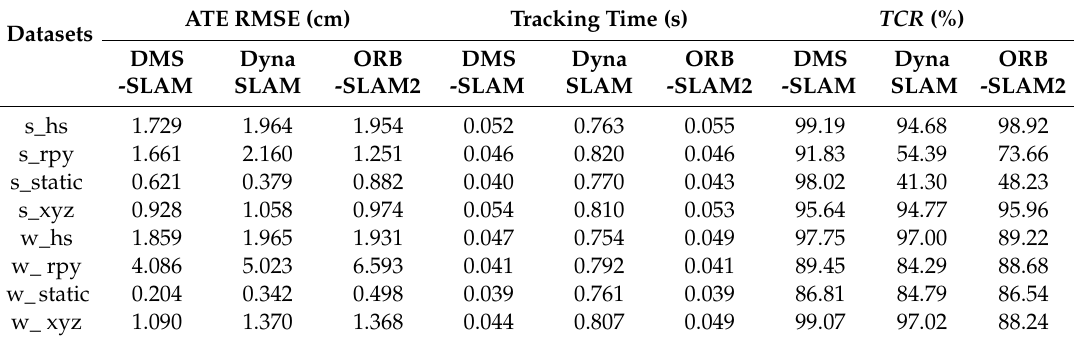
Table 3. Accuracy, speed and TCR in low dynamic scenes (s_*) and high dynamic scenes (w_*). Datasets